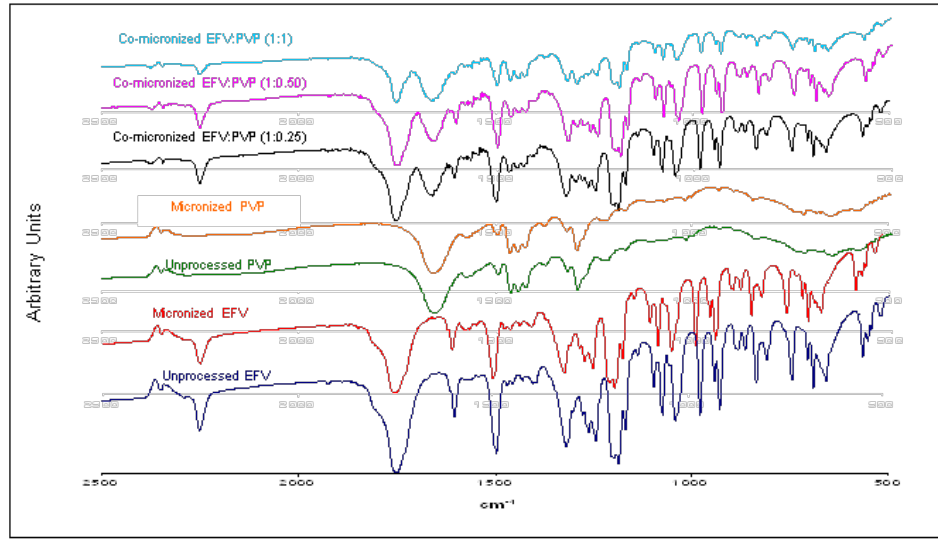
Figure 5. FITR spectra of unprocessed and micronized efavirenz and PVP and co-micronized mixtures EFV:PVP (1:0.25), (1:0.50) and